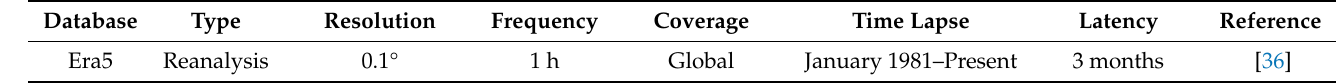
Figure 6. Precipitation values in Antioquia Department, Colombia by the Global Precipitation Measurement (GPM). Table 2. Characteristics of the selected global database for soil moisture and surface run